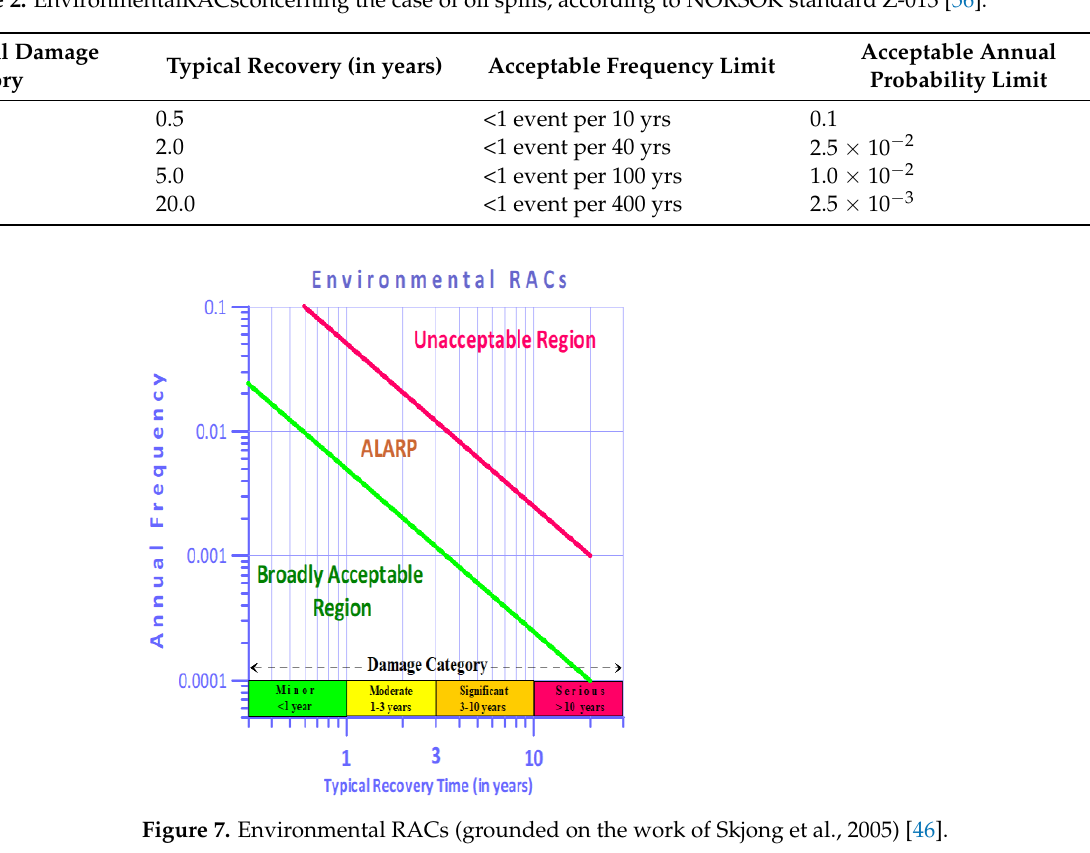
Table 2. EnvironmentalRACsconcerning the case of oil spills, according to NORSOK standard Z-013 [56].